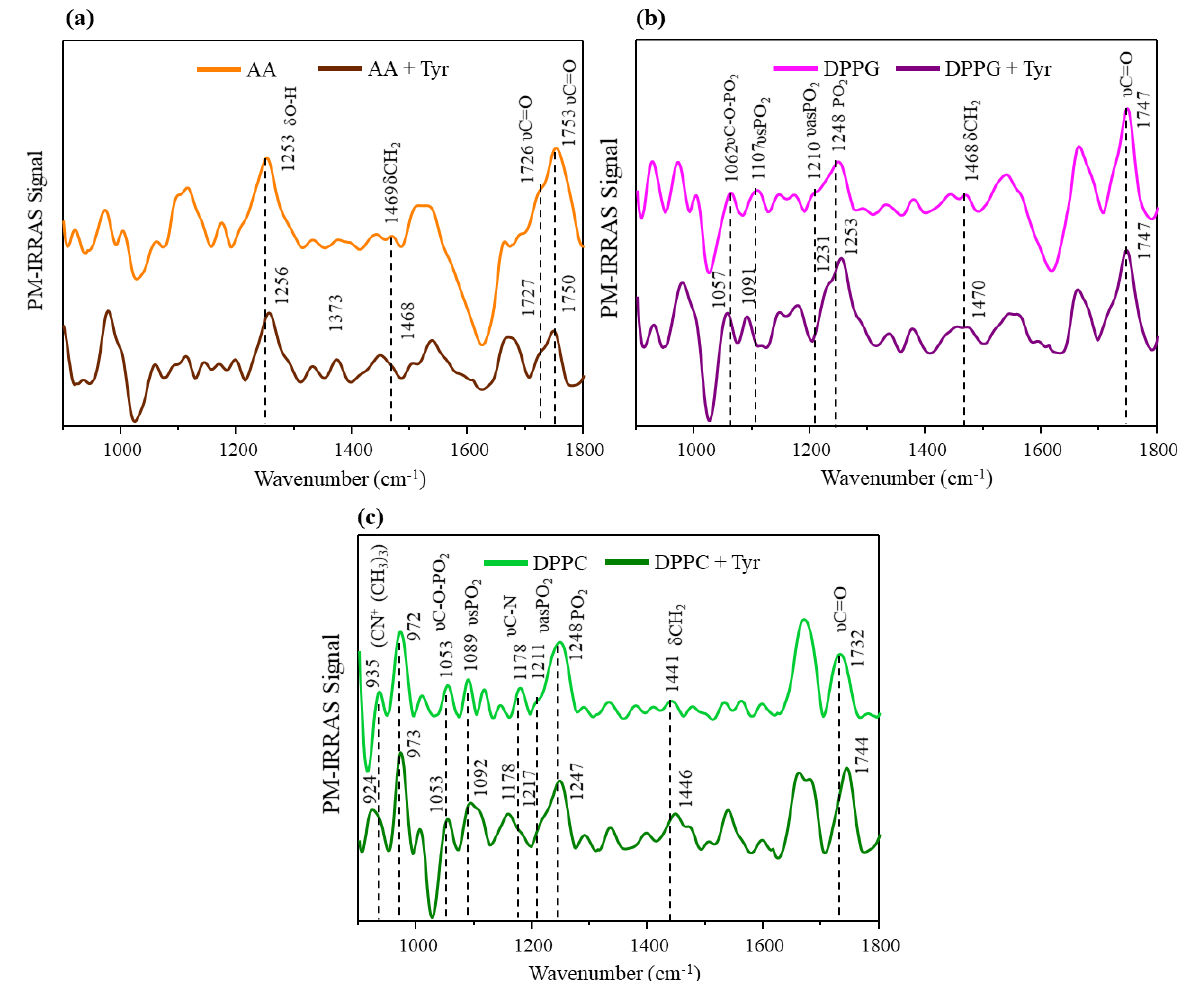
Figure 3. PM-IRRAS spectra at room temperature (~23 °C) and 30 mN/m for neat monolayers and Tyr-containing monolayers on the buffer subphase (1.74 mg mL -1 ) of AA ( a ), DPPG ( b ) and DPPC ( c